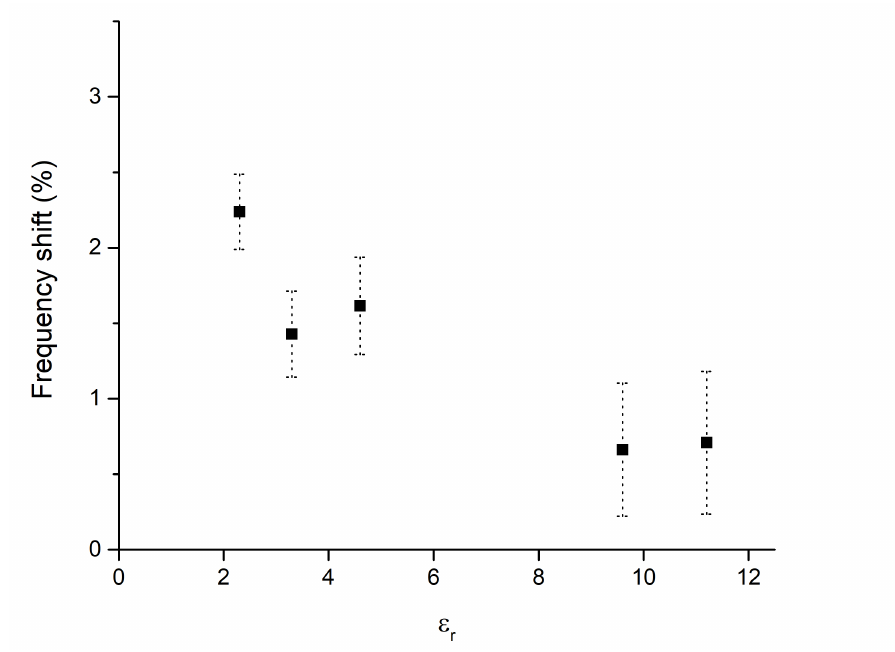
Figure 4. Sensor sensitivity, calculated as a percentage of frequency shift, in the range 0.3–3% RH, as a function of the substrate ε r . The error bar is calculated from the simulation frequency